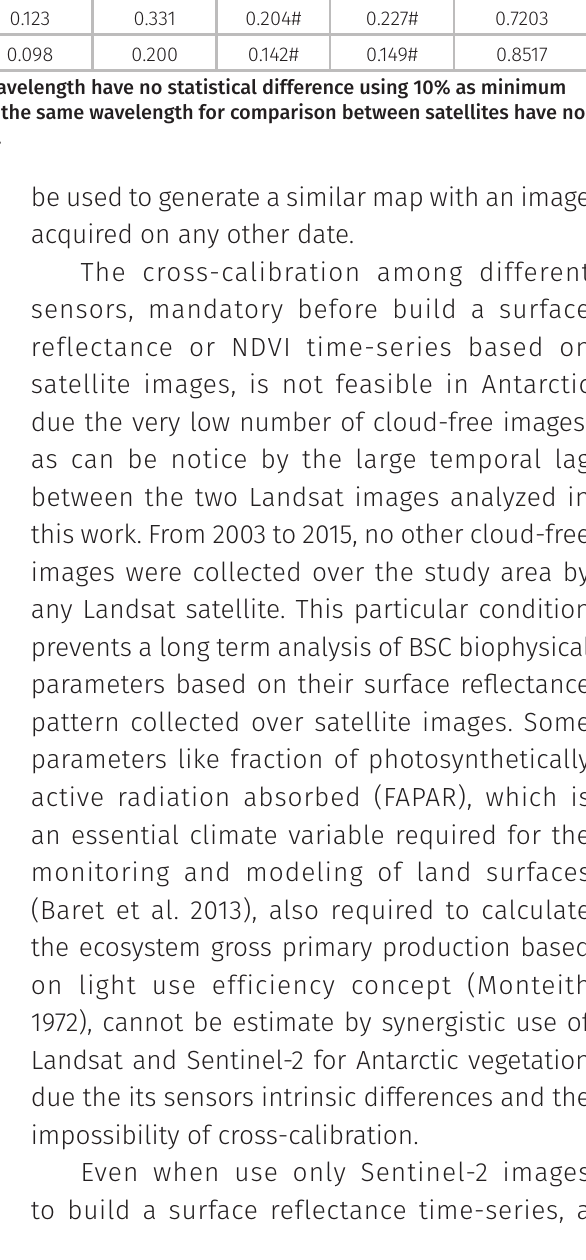
statistical difference using 10% as minimum level of